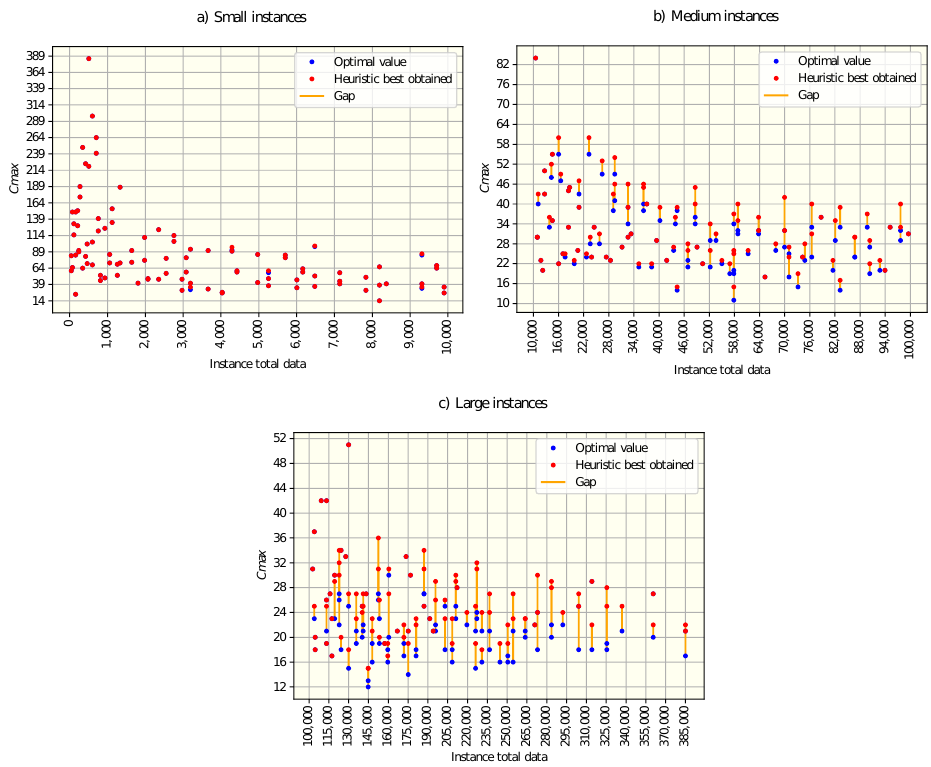
Figure 6. Differences between optimal and the best heuristic value for: ( a ) Small, ( b ) Medium and ( c ) Large